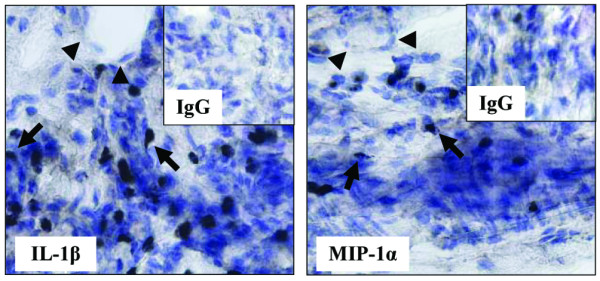
Macrophages stain positive for IL-1β and MIP-1α in the joints of nonimmunized E/P-selectin mutant mice. Immunohistochemistry for IL-1β and MIP-1α in synovial tissue of E/P-selectin mutant CIA mice. Staining for both cytokines showed clear immunopositivity on macrophages (arrows), whereas ST endothelial cells (arrowheads) remained negative. Original magnification: 400×. CIA, collagen-immunized arthritis; MIP, macrophage inflammatory protein; wt, wild-type.